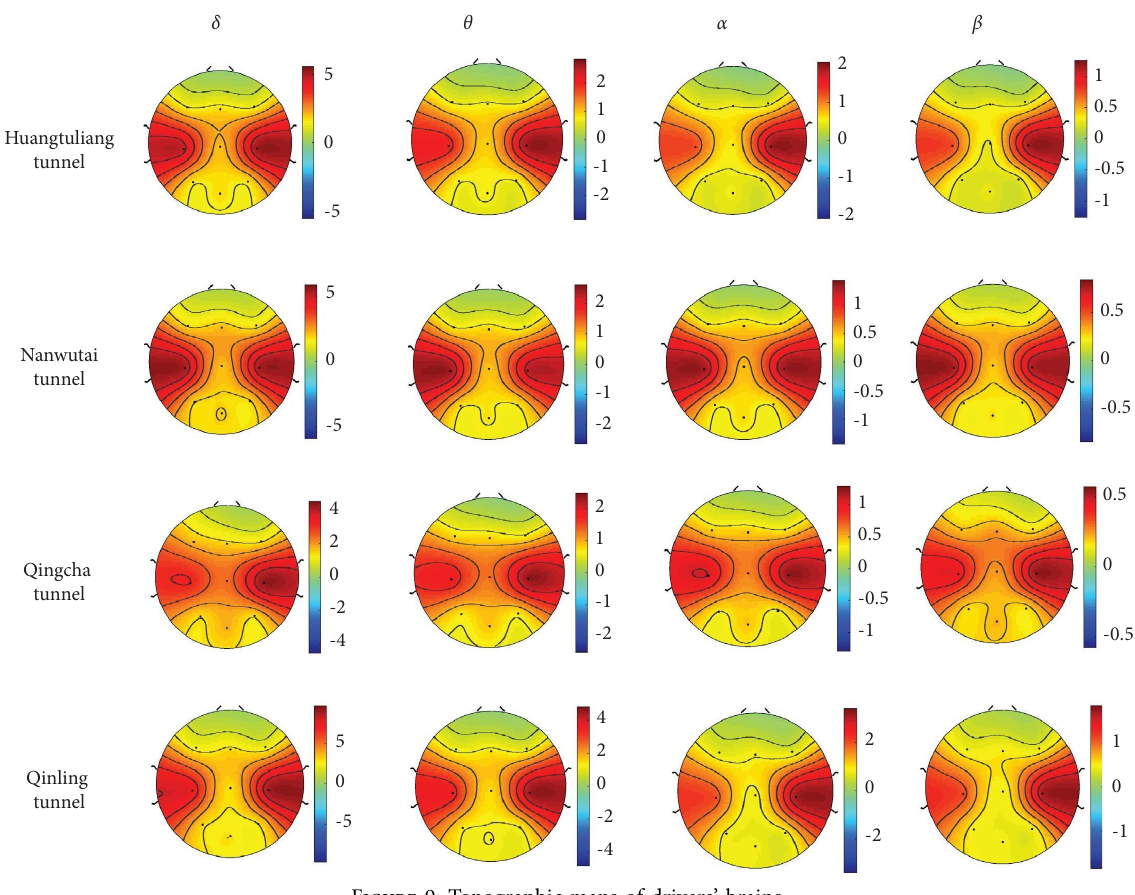
Figure 9: Topographic maps of drivers’ brains.